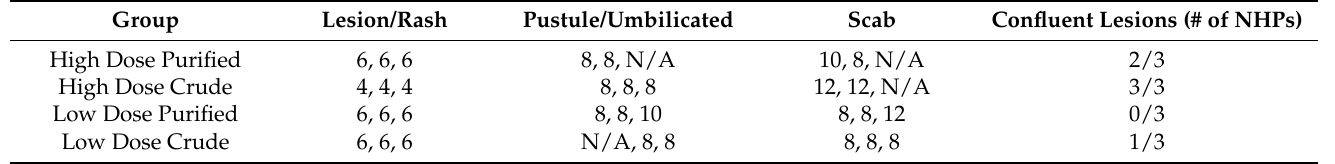
Table 3. Key features of the onset and progression of rash, by animal and day of